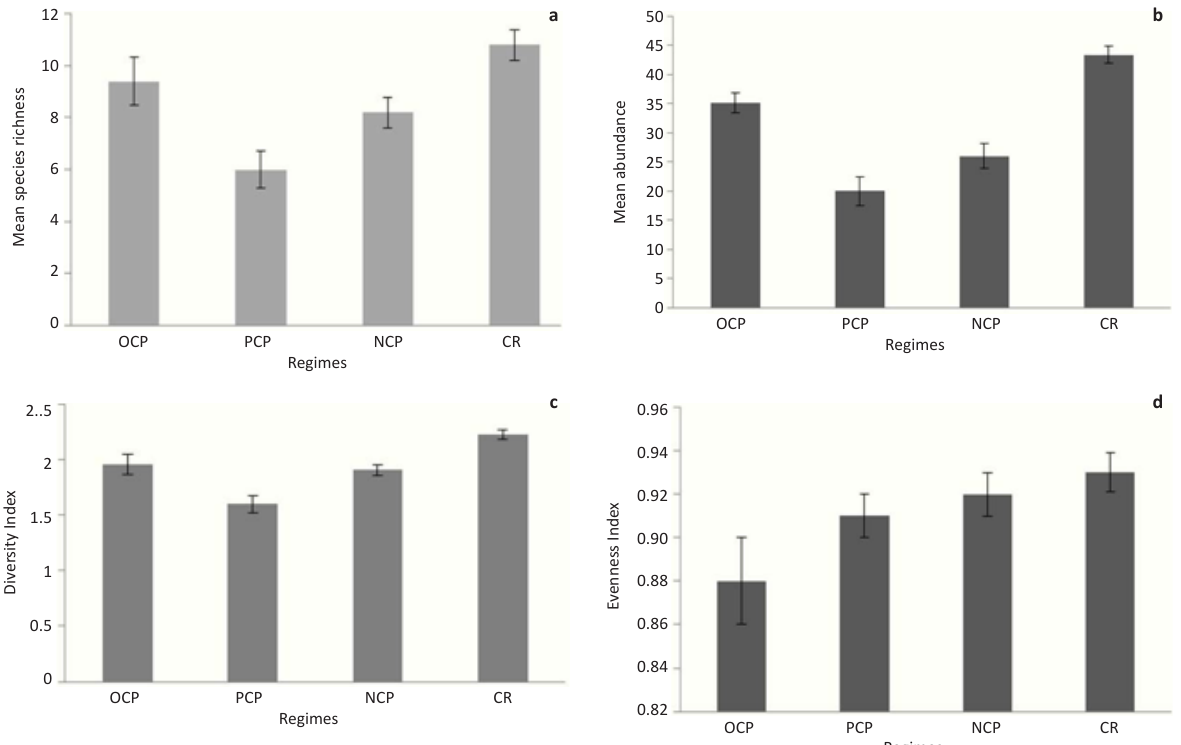
Figure 2a–d. a - Mean species richness of amphibians across sites; b - Mean abundance across sites; c - diversity index across sites; d - Evenness index across